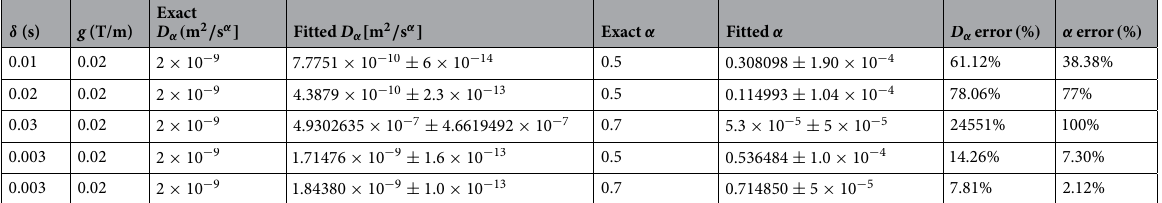
Table 5. Fit parameters of the synthetic curves obtained from CTRW